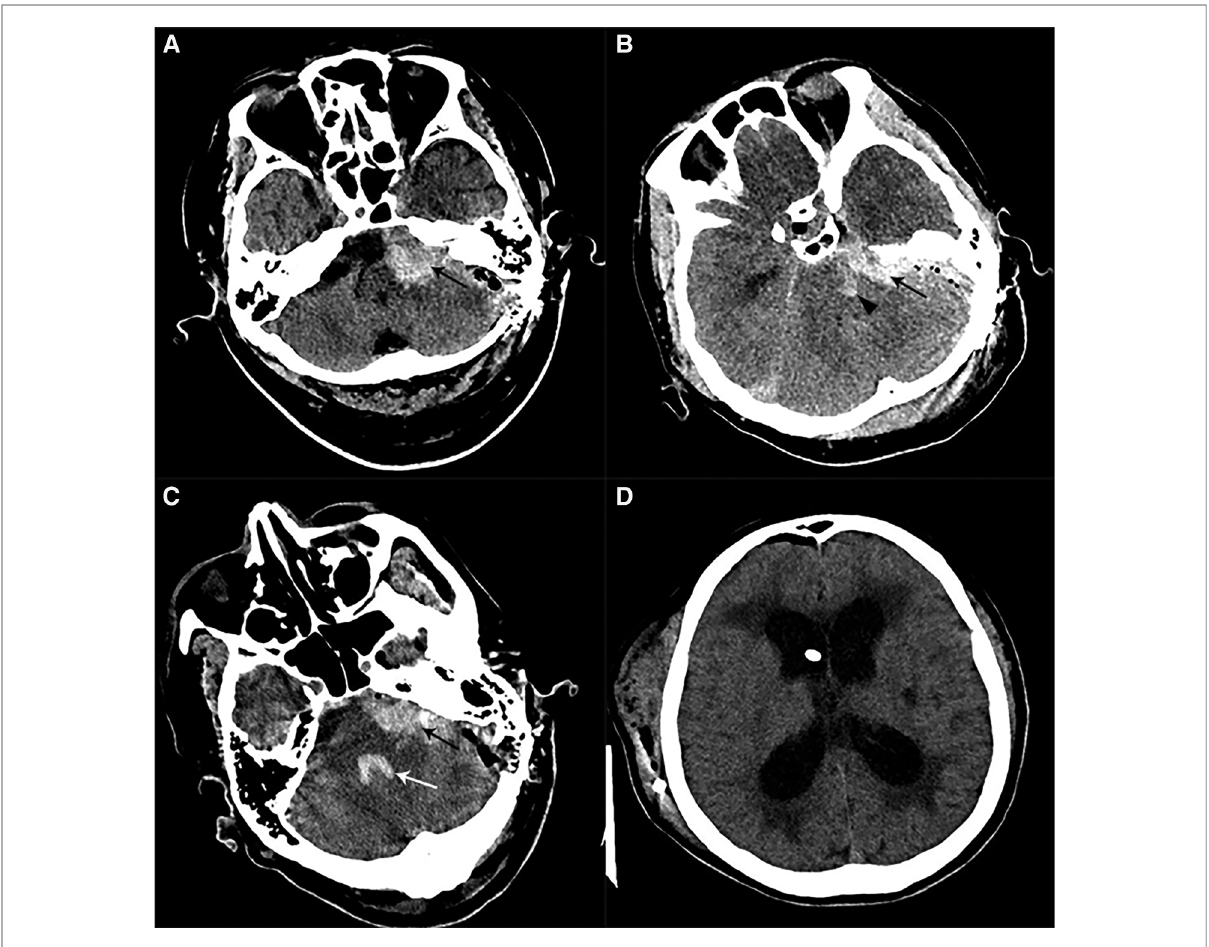
FIGURE 3 Postoperative imaging of patients with CPA hemorrhage. ( A ) Postoperative CT in a patient with left HFS showed a left CPA hemorrhage alone (black arrow). ( B ) Postoperative CT in one patient with left HFS showed CPA hemorrhage (black arrow) combined with brainstem hemorrhage (black arrowhead). ( C ) Postoperative CT in a patient with left HFS and TN showed a left CPA hemorrhage (black arrow) involving the fourth ventricle (white arrow). ( D ) We performed a V-P shunt on the patient who had experienced hydrocephalus two months after the CPA hemorrhage. CT showed a lateral ventricle enlargement, periventricular hydrocephalus, and distal stoma of the